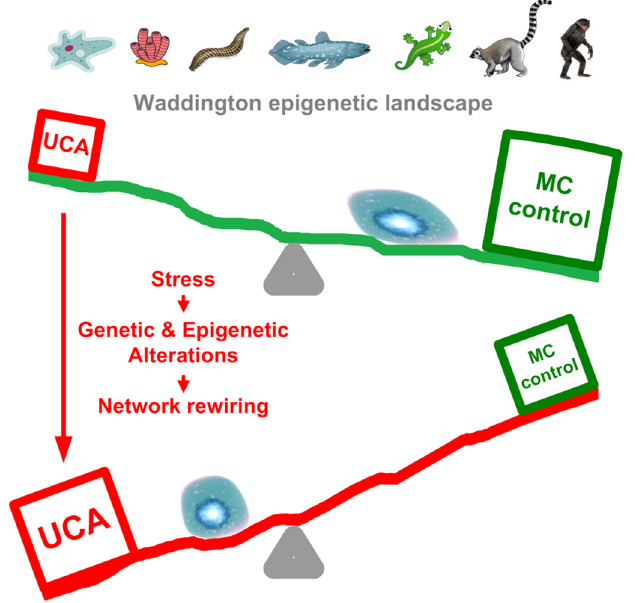
Figure 11. The Waddington epigenetic landscape of ontogenesis (reflected in cell differentiation) and its reversal by the activation of UC attractor as a result of genetic and epigenetic alterations caused by external and endogenous stress. The evolutionary stages at the top are visualized by recent representatives. (According to the biogenetic law, ontogenesis roughly recapitulates phylogenesis [57,72].)